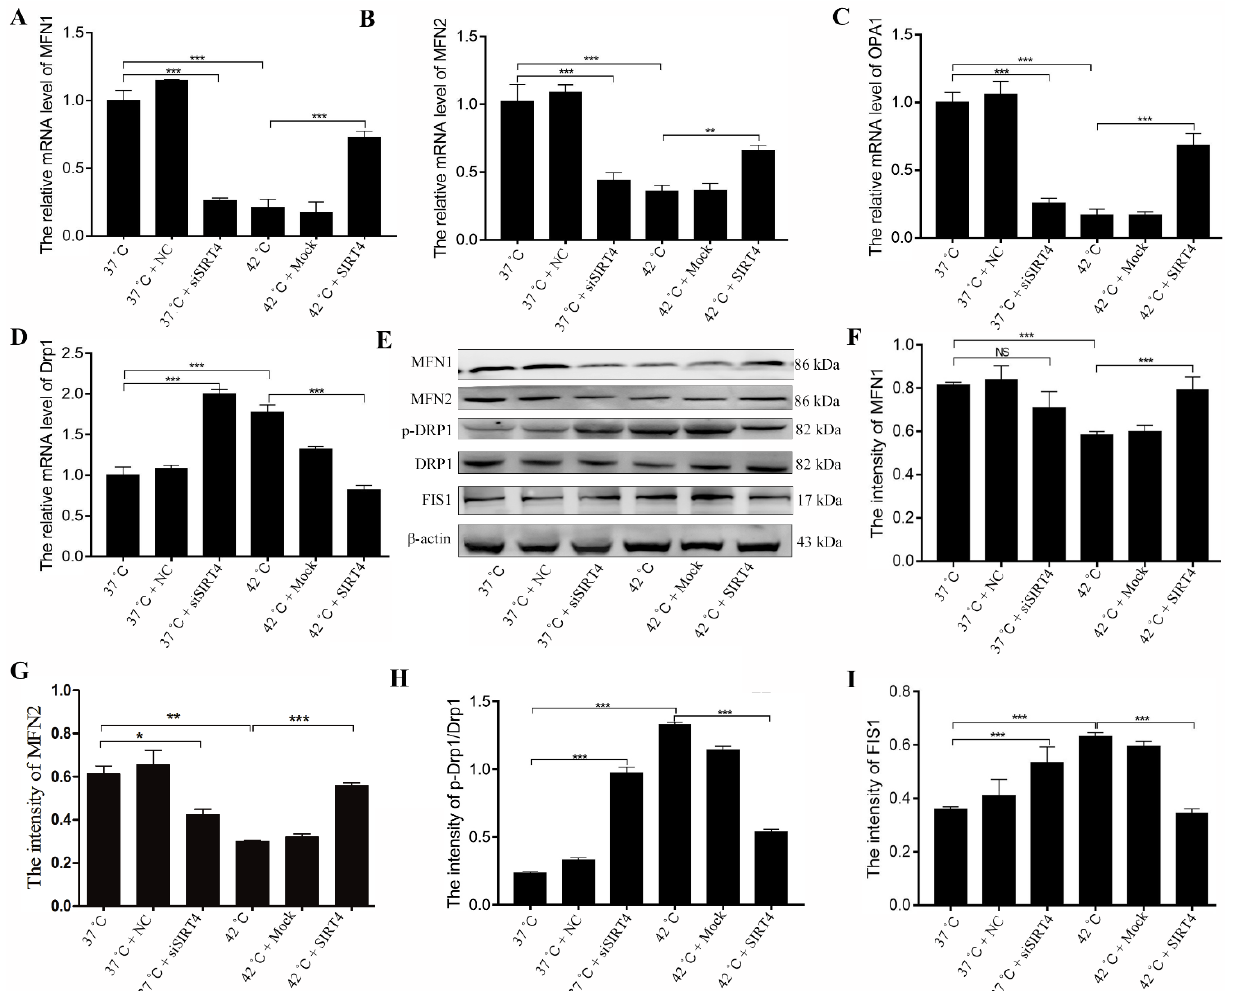
Figure 3. SIRT4 inhibited mitochondrial division and promoted its fusion induced by heat